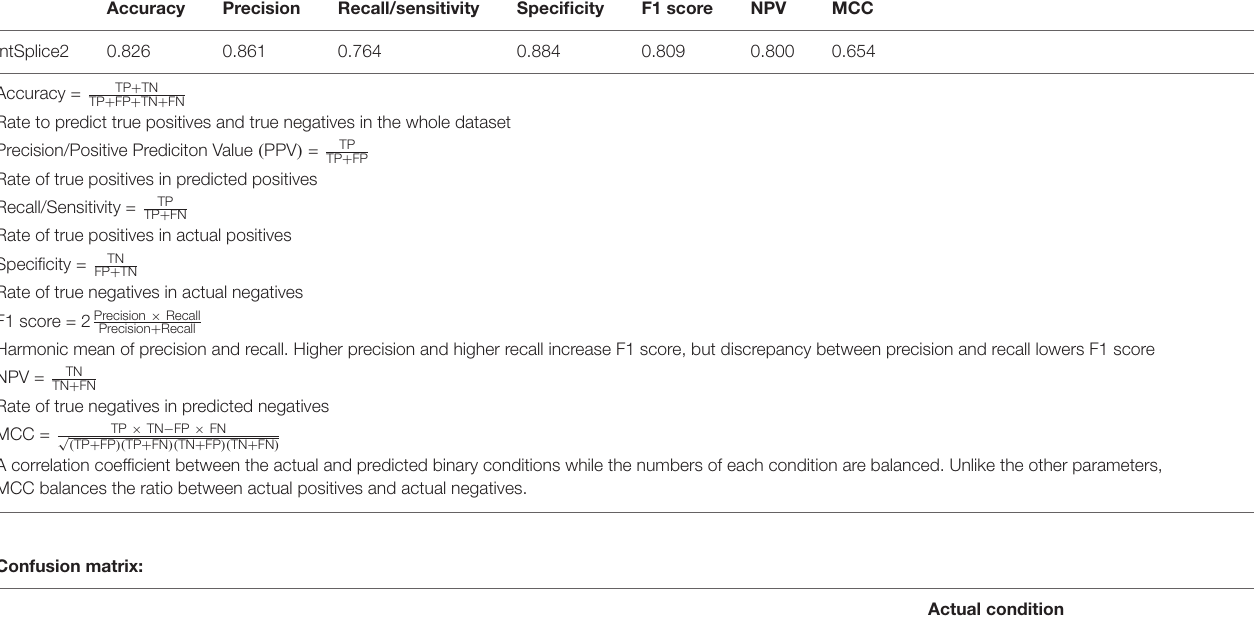
TABLE 1 | Seven statistical measures indicated in the Human Mutation guidelines (Vihinen, 2013; Grimm et al., 2015) of IntSplice2 by fivefold CV of Training Dataset-1787.